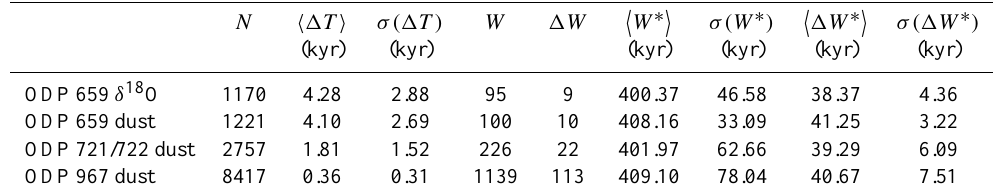
Table 1. Basic properties of the analysed palaeoclimate time series. N is the number of samples contained in the time series, h ∆ T i the mean sampling interval, and σ (∆ T ) the standard deviation of sampling intervals. For a desired window size W ∗ = 410 kyr and step size ∆ W ∗ = 41 kyr (as chosen in Sec. 4.1 for RN analysis), W and ∆ W give the corresponding window and step size (in numbers of observations), h W ∗ i and h ∆ W ∗ i the average effective window and step size, and σ ( W ∗ ) and σ (∆ W ∗ ) the associated standard deviations (in units of time).